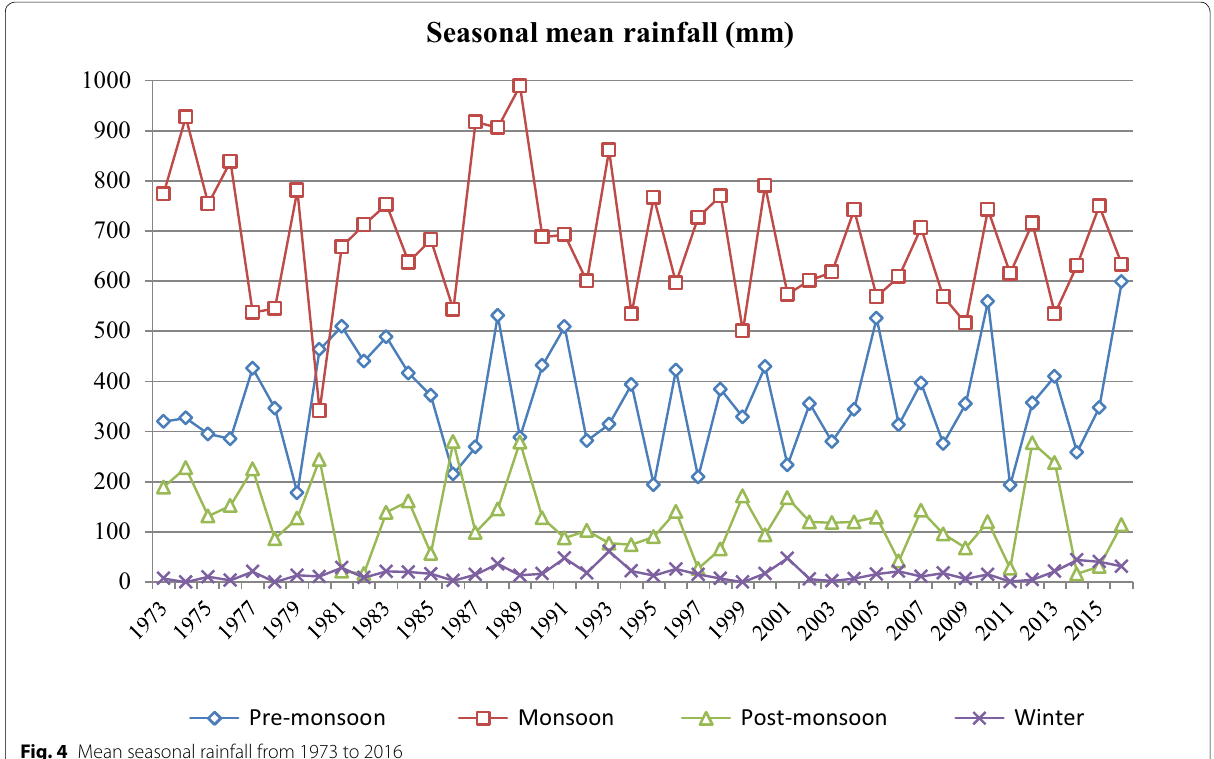
Fig. 4 Mean seasonal rainfall from 1973 to